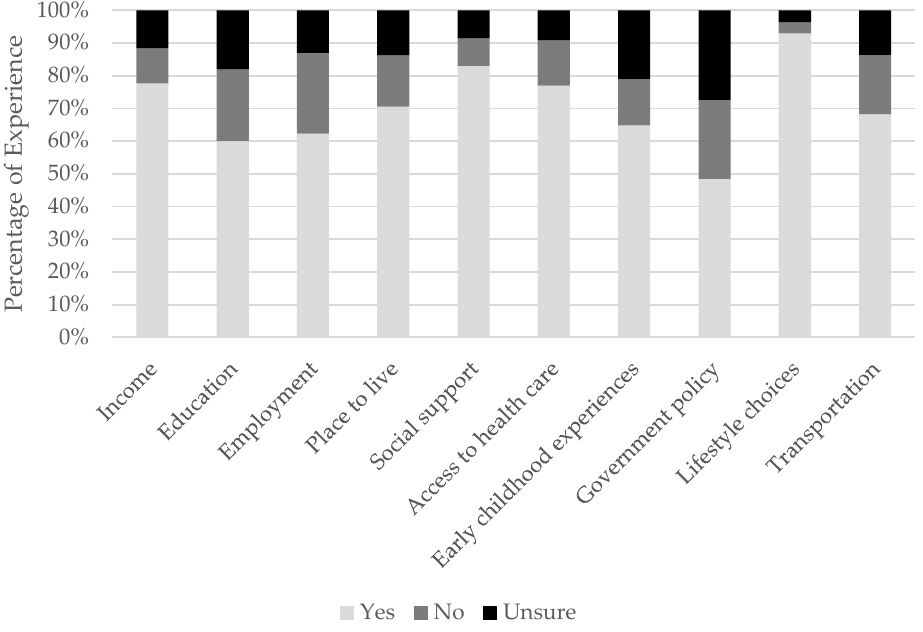
Figure 3. Athletic trainers’ experience managing social determinants of health when negatively influencing patient health and well-being.